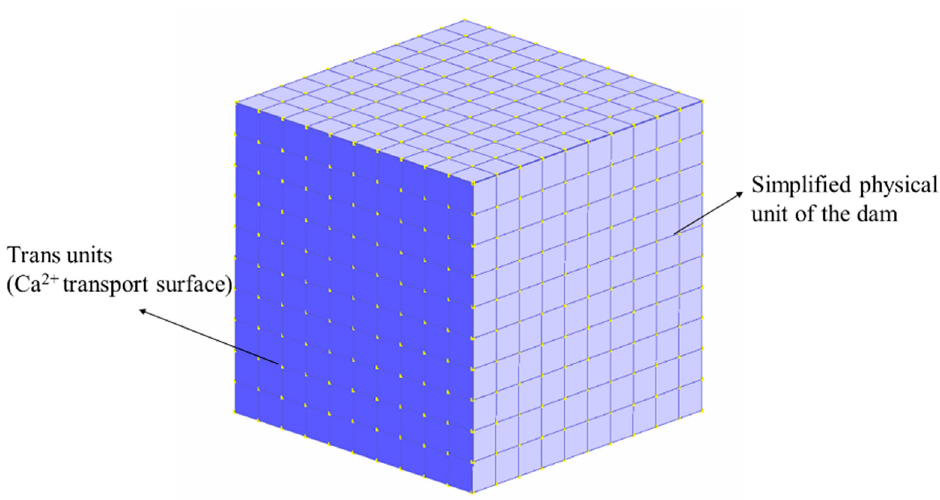
Figure 6. XPS analysis results: ( a ) the mass percentage of main components and ( b ) a representative XPS spectra graph.